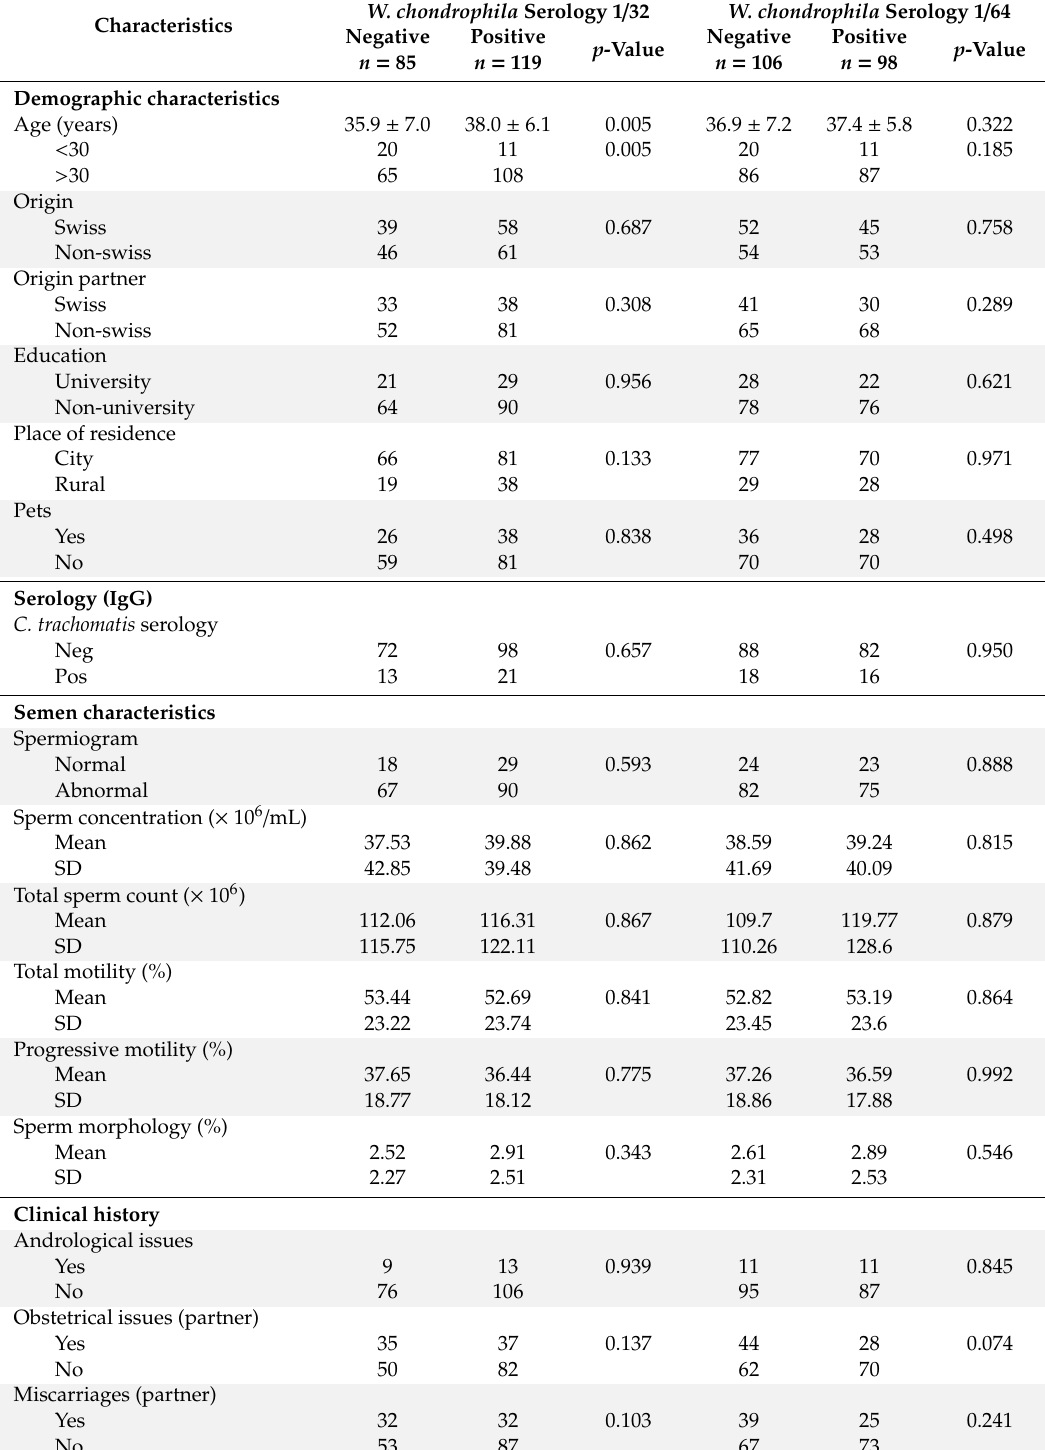
Table 2. Characteristics of patients according to W. chondrophila